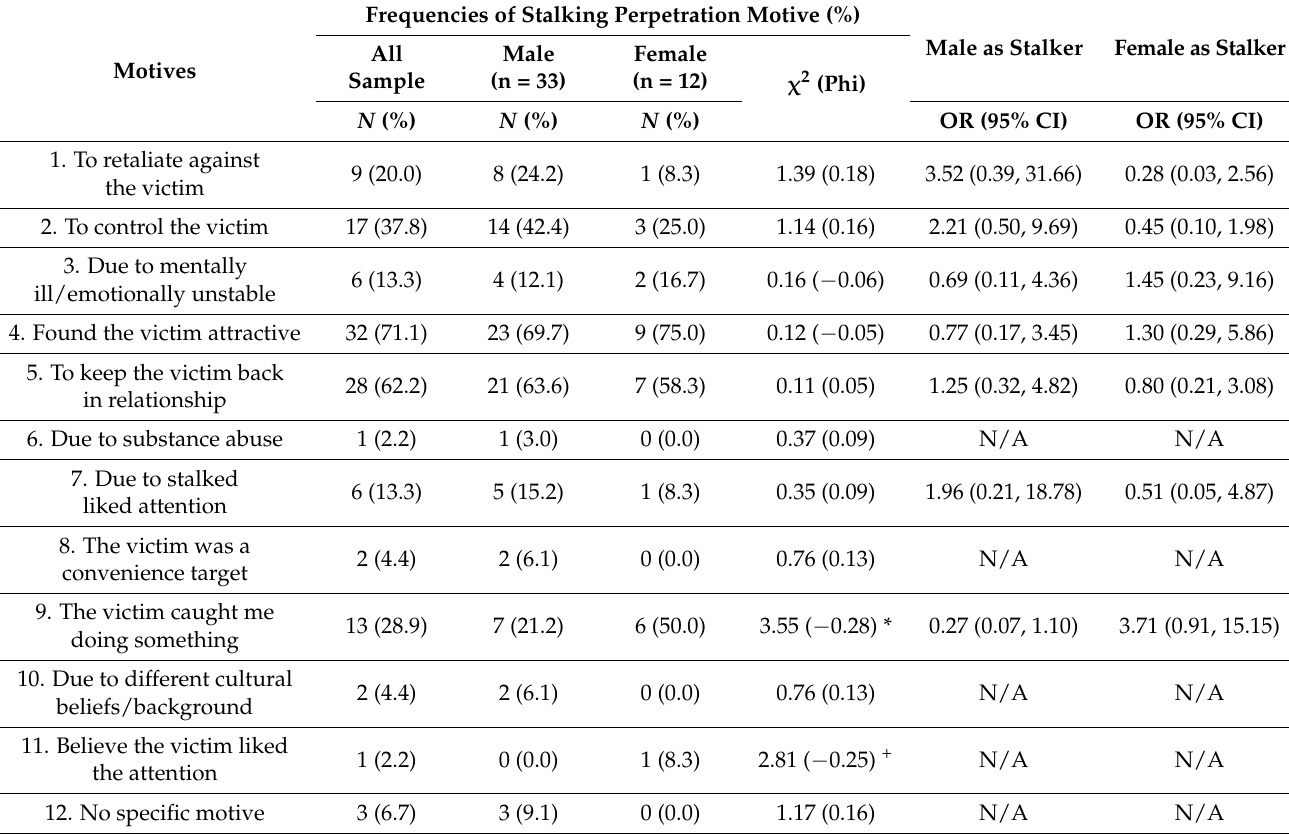
Male as Stalker Female as